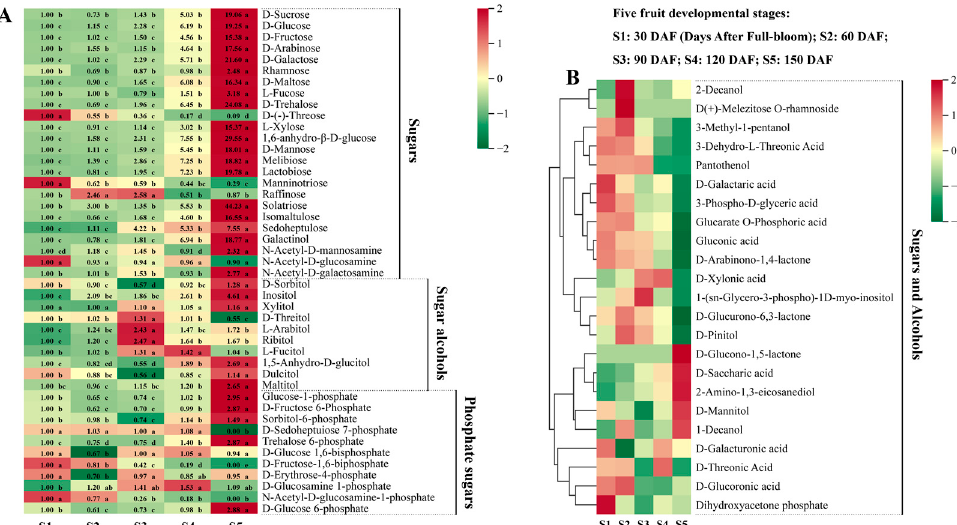
Figure 2. Sugar and alcohol metabolites detected at the five fruit developmental stages through broadly targeted UPLC-MS/MS. ( A ) Types and contents of sugars, sugar alcohols, and phosphate sugars in ‘Shandong Dajinxing’ fruits at the five developmental stages. S1, S2, S3, S4, and S5 represent the five fruit developmental stages of 30, 60, 90, 120, and 150 days after full-bloom (DAF), respectively. The first period of 30 DAF was used as a calibration value to calculate metabolite ploidy across the five periods. Significance analysis was performed using SPSS software with Tukey’s test and using a threshold of p < 0.05; the results are indicated by lowercase letters a, b, c, d, and e in the figure. Different letters indicate different levels of significance for comparisons between two samples. ( B ) Changes in the contents of other sugar and alcohol metabolites across the five periods of fruit development. Different colors on the heat map indicate the proportional contents of each metabolite, as determined based on the mean peak response area normalized to an R scale. Three independent biological replicates were assessed for each period.